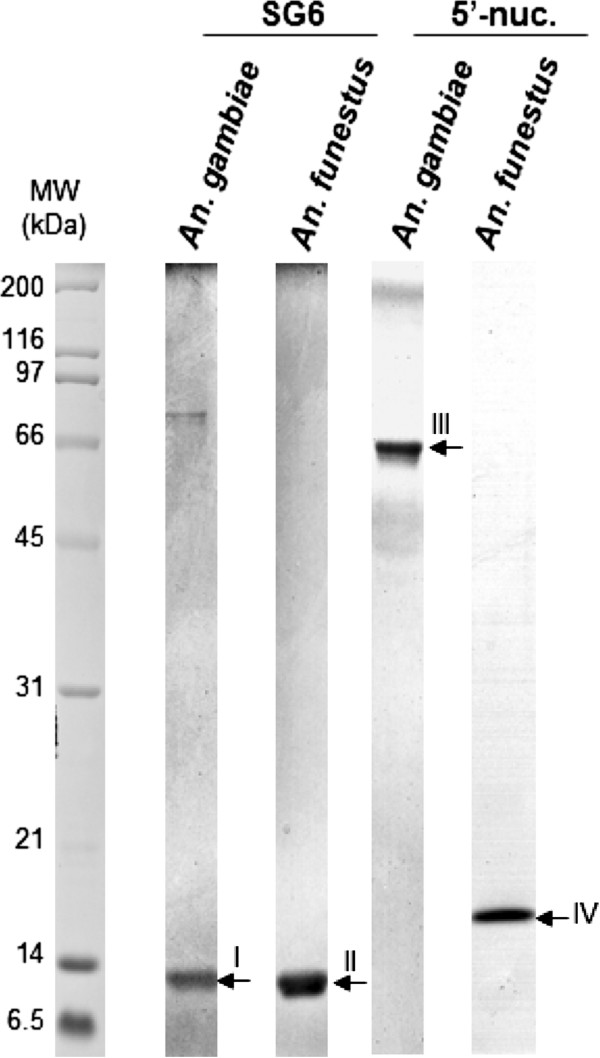
The assessment of the expression and purification of anophelines salivary proteins. Recombinant ortholog forms of SG6 and 5′nucleotidases from An. gambiae and An. funestus expressed in Spodoptera frugiperda (Sf9) cells and purified by affinity and gel filtration chromatography were separated on a 15% SDS-PAGE and post-stained with Imperial™ Protein Stain (Thermo Scientific). Five micrograms of each collected fraction were loaded per well. The protein name and the Anopheles species corresponding to each well are indicated at the top of the gel. The Roman numeral numbers on the right side of the gel correspond to the band numbers excised for identification by mass spectrometry. Band identity is listed in Table
2. Standard molecular weights are indicated on the left side. MW: molecular weight. kDa: kilodalton.